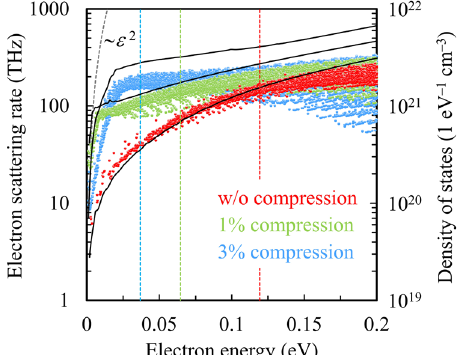
Fig. 3 Ab initio e-ph scattering rates of n -type SnTe at 300 K with a doping concentration of 10 20 cm − 3 . The red, green, and blue dots represent the crystal at 0%, 1%, and 3% compression, respectively, and the vertical dashed lines with the same colors show the Fermi energies at this doping concentration. The black lines next to the dots are the corresponding electron DOSs. The dashed gray line (cid:3) ε 2 law of the e-ph scattering rate. shows the τ (cid:2) 1 n k